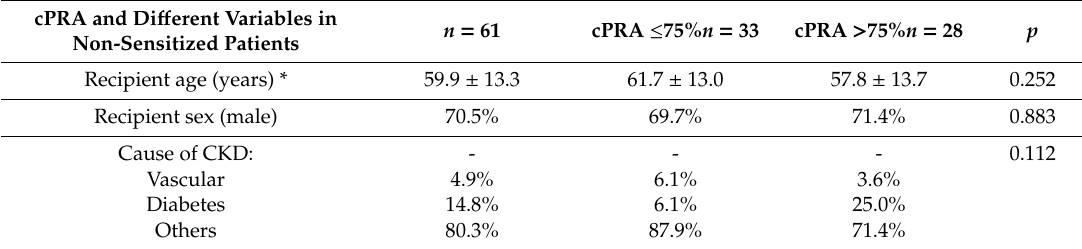
Table 3. Patient characteristics in relation to the development of cPRA ≤ or > 75% after transplant failure in previously non-sensitized patients. Continuous variables were expressed as mean ± SD (*) or median and interquartile range (ˆ) according to their distribution. The bold: p values less than 0.05 defined statistical